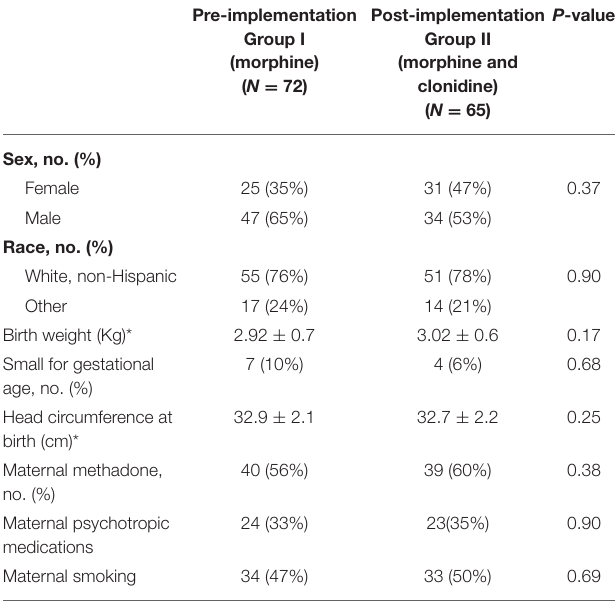
TABLE 1 | Demographics of participants in both study